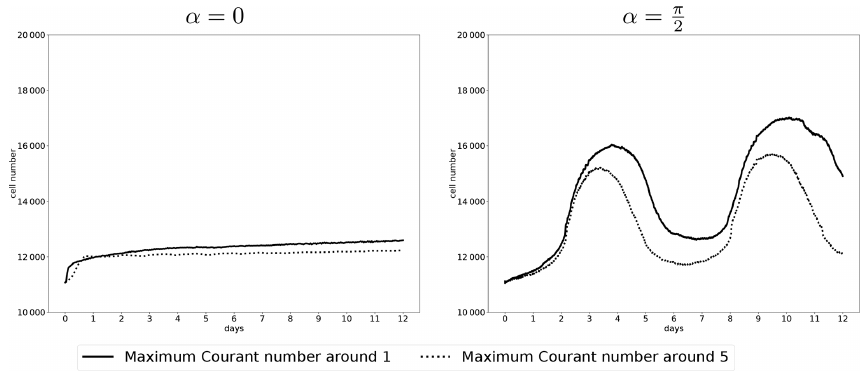
Figure 11. Evolution of the cell number rotating around the equator (left) and cross-pole transport (right) in the solid body rotation test case with a resolution of 2.5 ◦ × 2.5 ◦ . The solid line shows the cell number evolution with time when the Courant number is small, and the dashed line shows the cell number evolution with time when the Courant number is large.